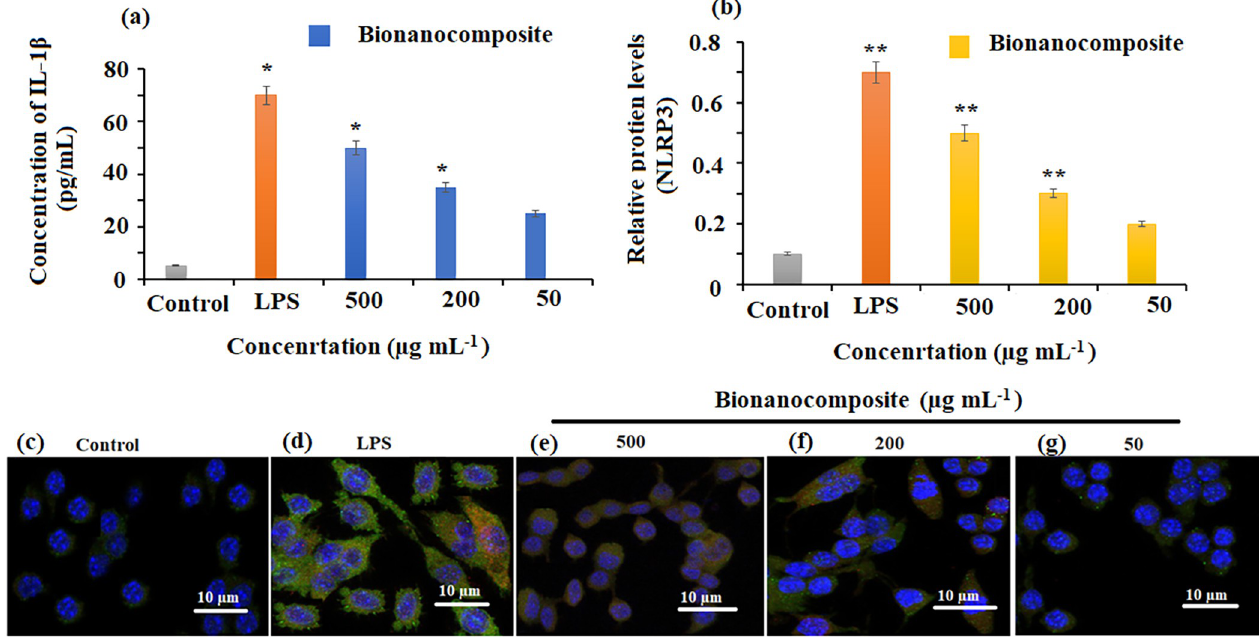
Fig 12. Effect of sunflower oil/FA–CSNPs bionanocomposite on the production of IL–1 β through activating of NLRP3 inflammasome in macrophages. (a) IL–1 β production in RAW 264.7 cells for 24 h. (b) The confocal fluorescence images of NLRP3 and ASC in macrophages. (c–g) the expression of NLRP3 antibody in RAW264.7 cells treated with bionanocomposite for 12 h. The values are calculated as mean ± standard deviation (n = 3). Significant differences with control cells were expressed as * P < 0.05 or ** P < 0.01.